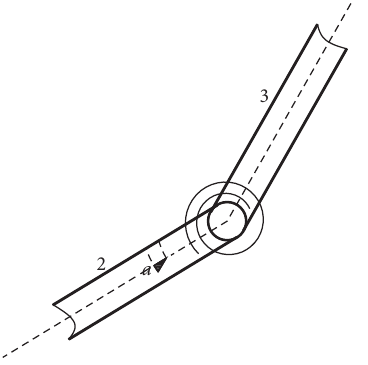
Figure 5: The limited rotation metamorphic joint. Table 1: Geometric and physical parameters of the open-loop three-bar constrained metamorphic